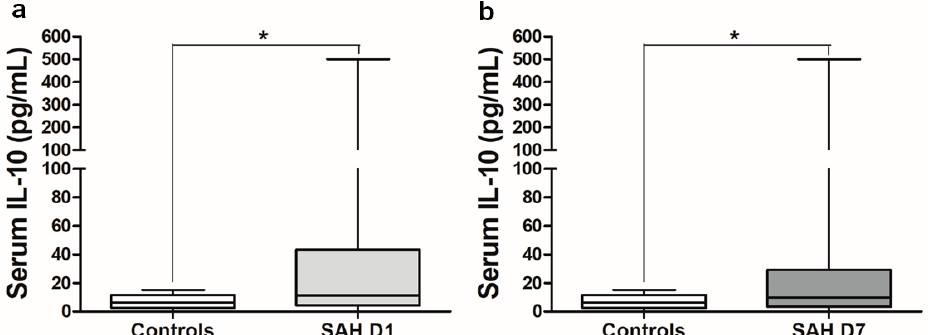
Figure 2. Serum IL-10 levels in control and SAH patients. ( a ) Serum IL-10 levels in control ( n = 24) and